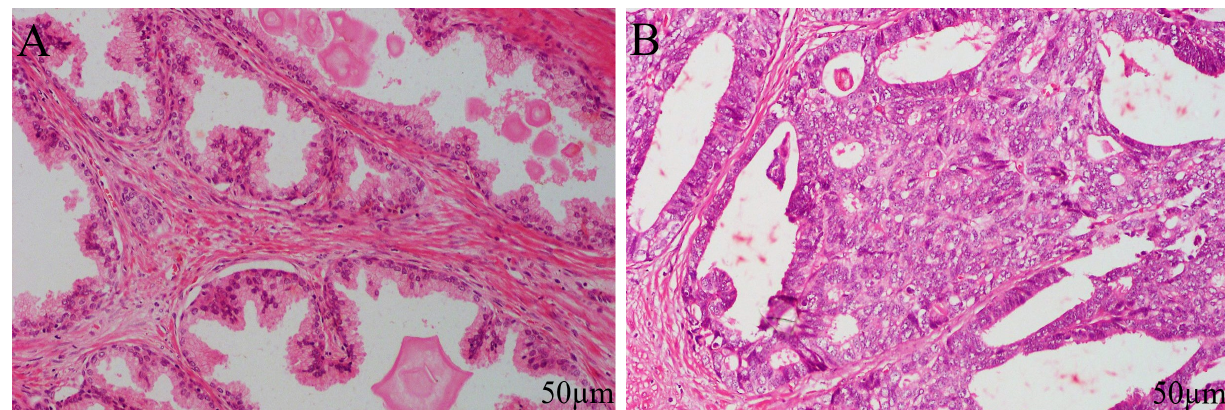
Fig. 1. Prostate tissue. (A) Adenomatous hyperplasia. Note the hyperplastic prostate glands (H&E, × 200). (B) Prostate adenocarci- noma. The cancerous glands in this image show nuclear enlargement, hyperchromasia, prominent nucleoli, and the absence of a basal cell layer (H&E, × 200).